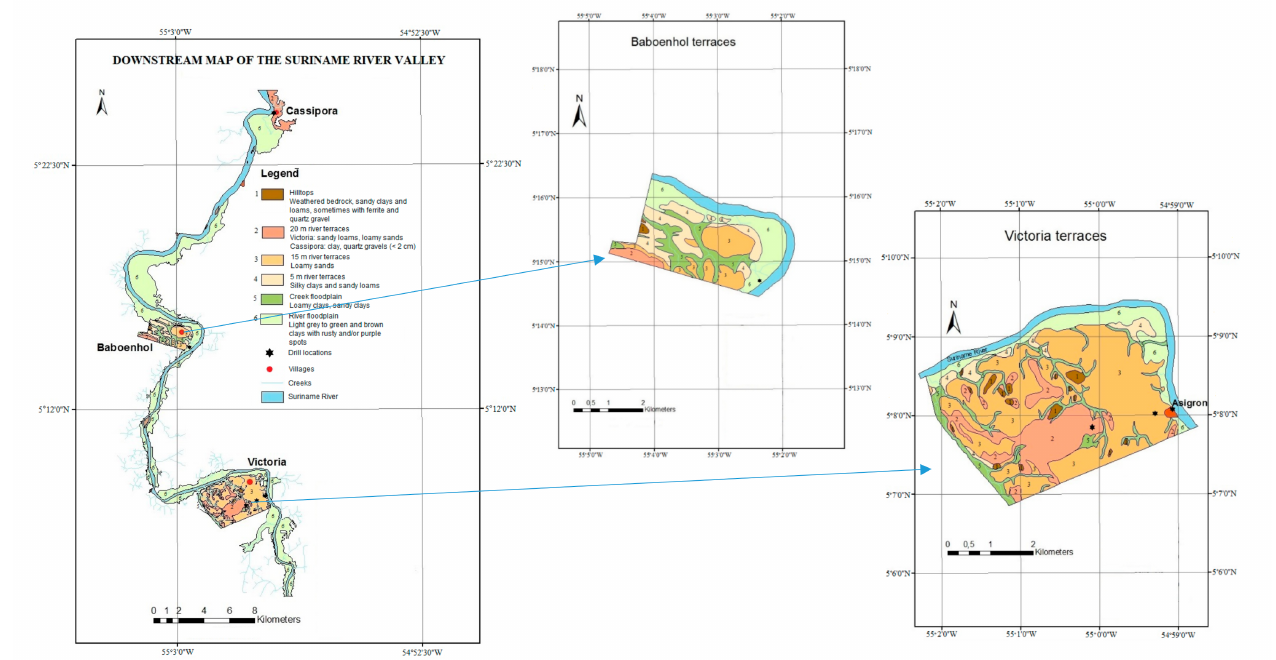
Figure 5. The downstream part of the Suriname River